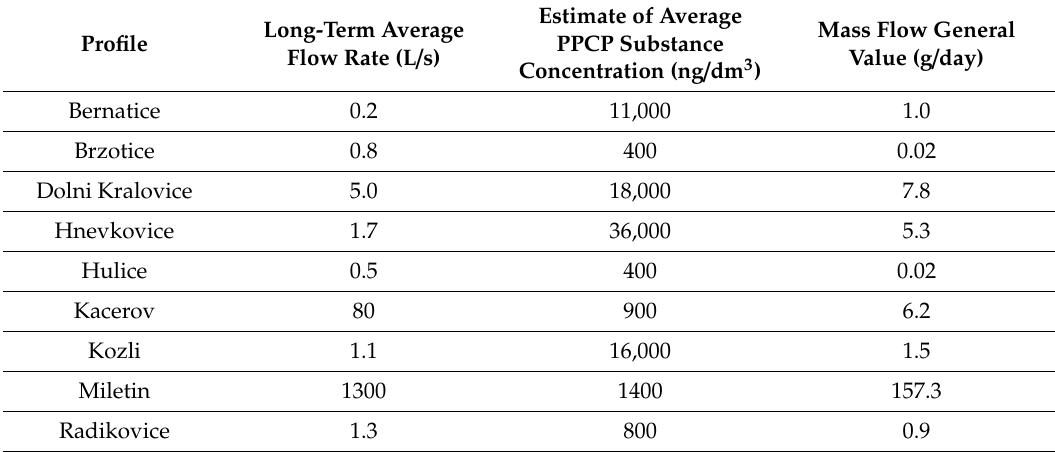
Table 14. Estimates of mass flow of PPCP substances into reservoir Svihov by concentration and flow